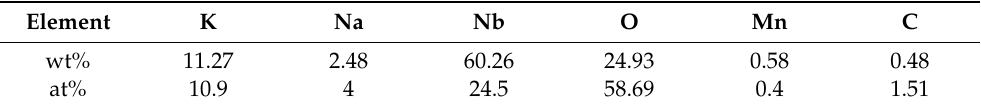
Table 2. Element contents in the